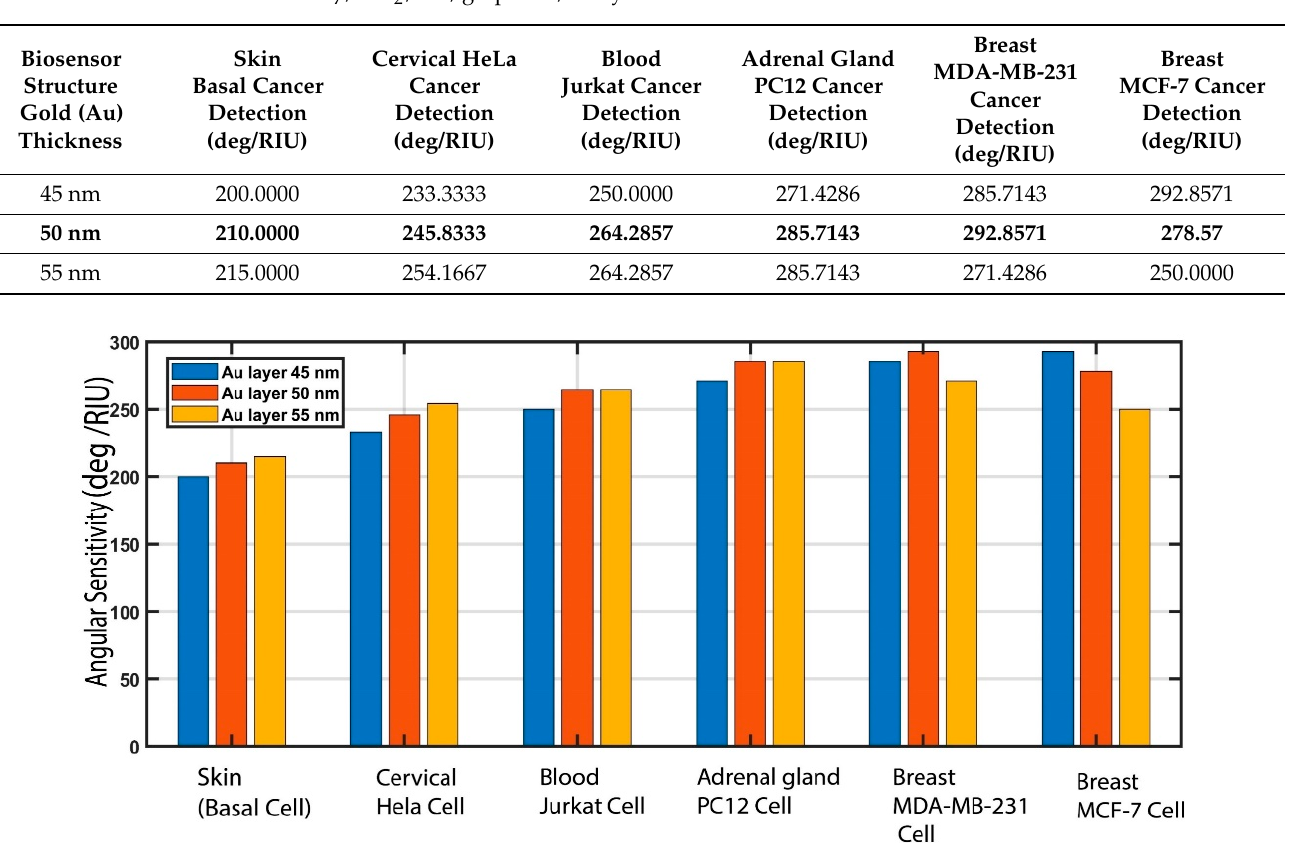
Analysis of gold (Au) layer thickness on the angular sensitivity of the proposed BK 7 /TiO 2 /Au/graphene/analyte biosensor for cancer detection.